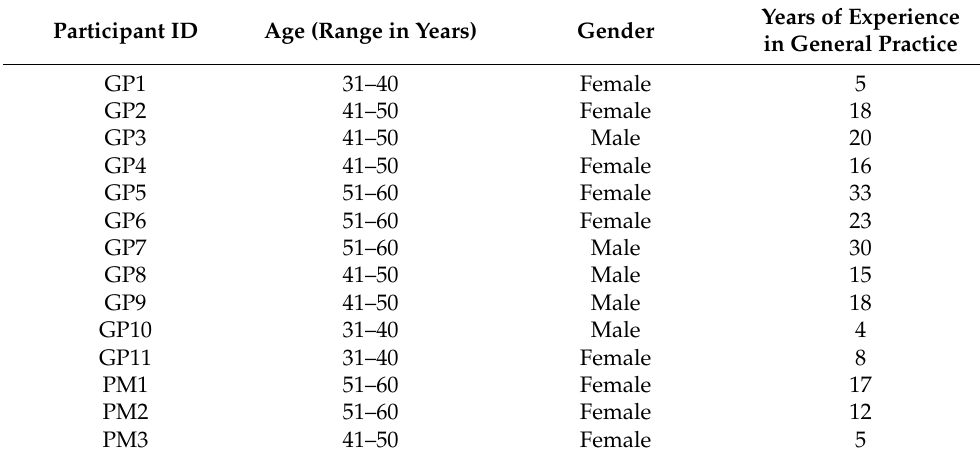
Table 1. Demographics of GPs and practice managers (PM) participated in the focus groups and